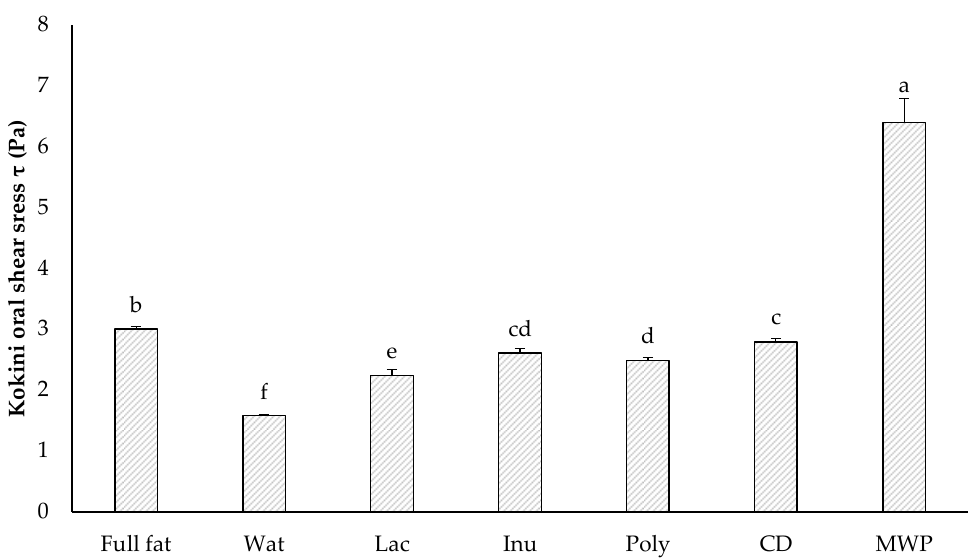
Figure 1. Kokini OSS of all emulsion samples. The data are expressed as the mean ± standard deviation ( n = 9). Bars with different letters indicate significant differences between samples ( p ≤ 0.05) following one-way ANOVA (Tukey).